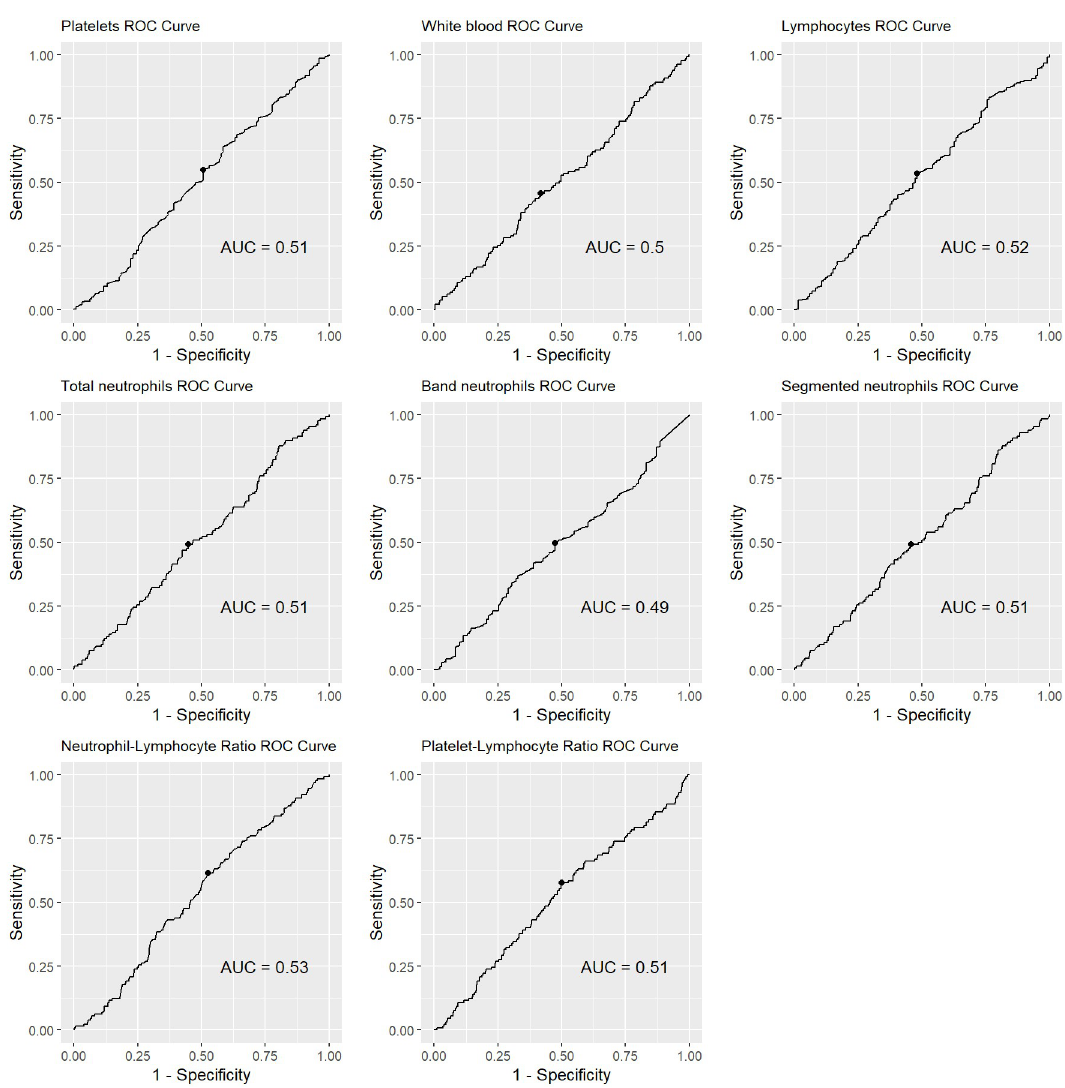
Fig 2. Receiver operating characteristic curve demonstrating area under curve of white blood count, lymphocytes, platelets count, total neutrophils, band neutrophils, segmented neutrophils, neutrophil-lymphocyte ratio and platelet-lymphocyte ratio for the occurrence of gestational trophoblastic neoplasia among patients with complete hydatidiform mole.